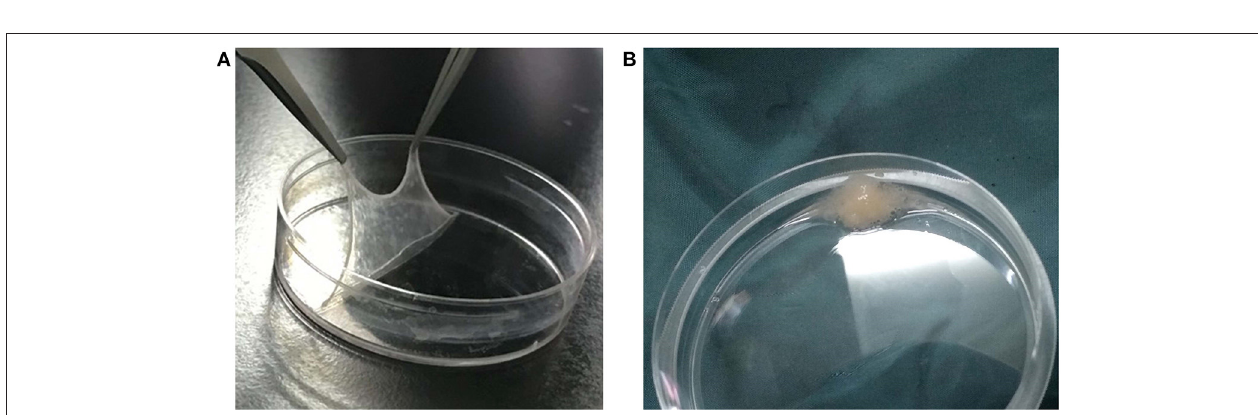
FIGURE 3 | Bone marrow mesenchymal stem cell (BMSC) sheets and sheet fragment suspension: (A) is the BMSC sheet; (B) demonstrates the BMSC sheet fragment suspension.